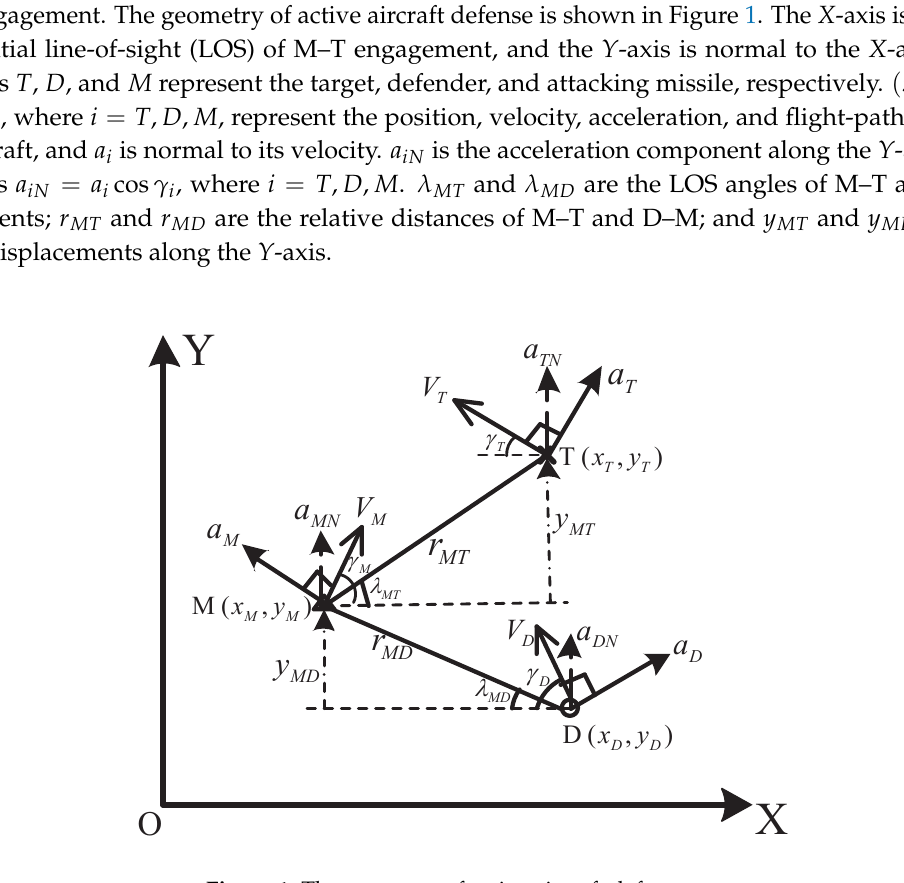
Figure 1. The geometry of active aircraft